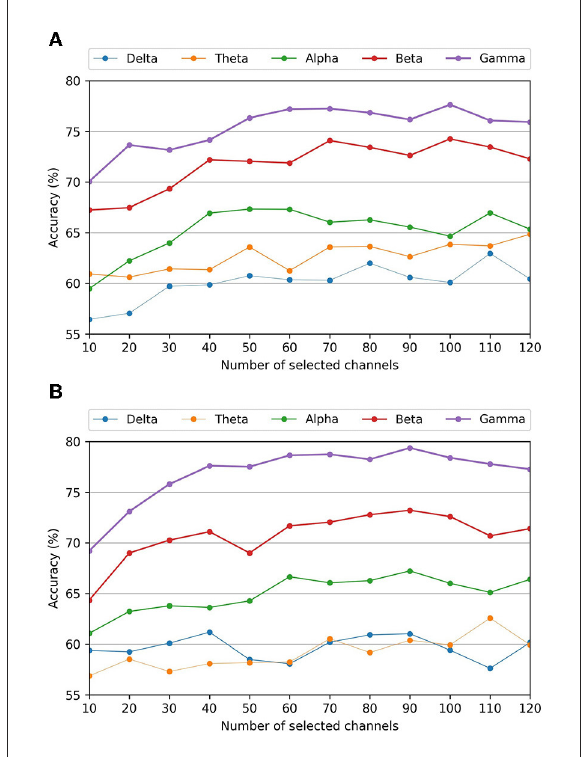
FIGURE4 Average classification accuracies of different frequency bands for the kurtosis-based channel selection as a function of the number of selected channels. (A) Valence scale classification accuracy. (B) Arousal scale classification